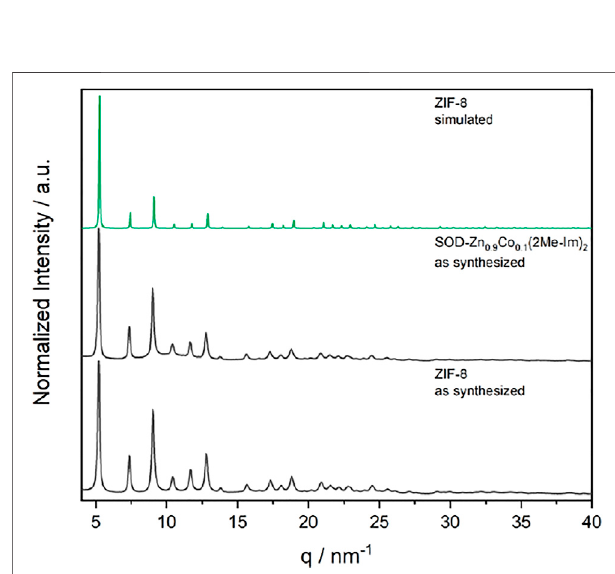
FIGURE 2 | XRD patterns of as-synthesized ZIF-8 and SOD-Zn 0.9 Co 0.1